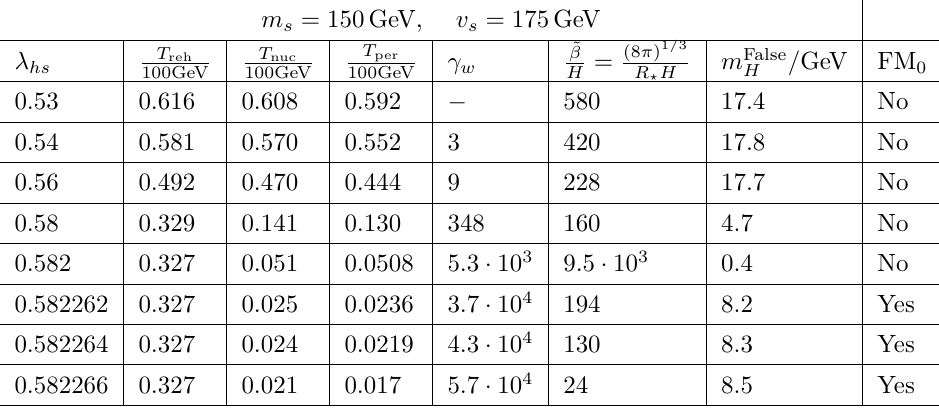
Table 3 . Same as tables 1 and 2, but with m s = 150 GeV and v s = 175